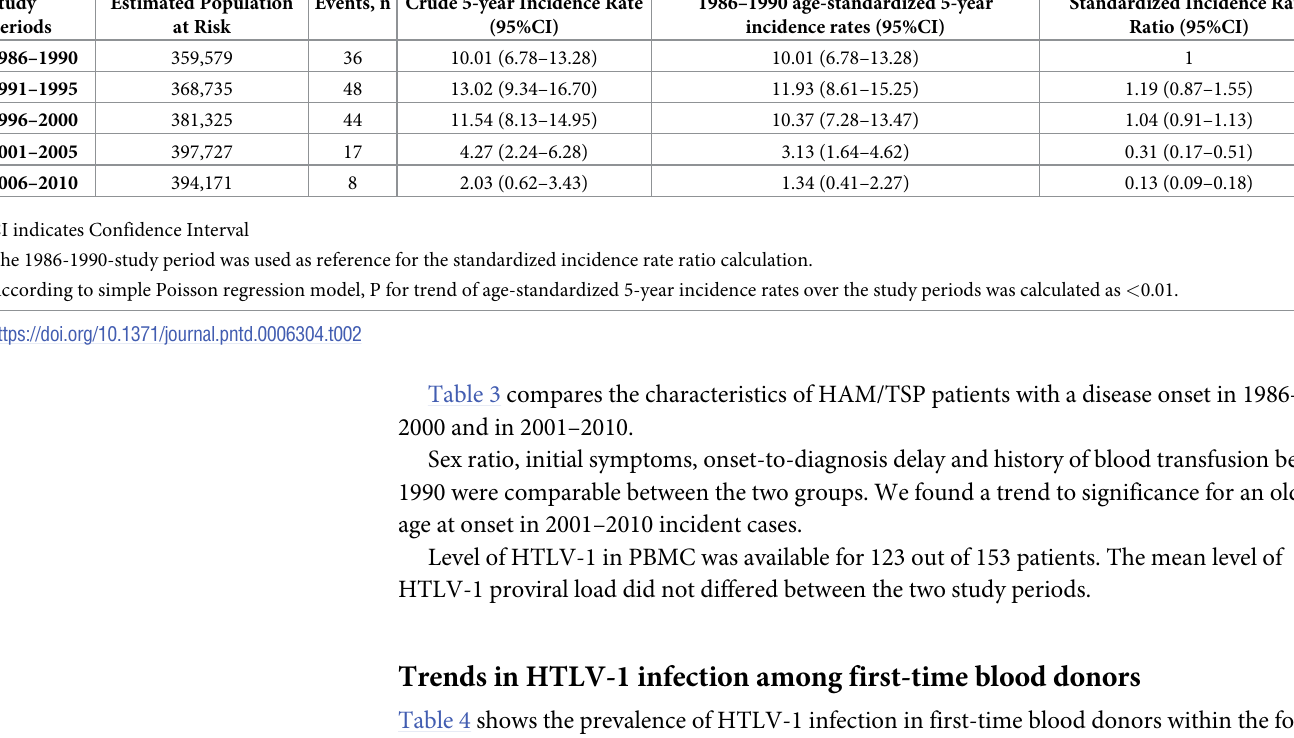
Table 2. Crude and age-standardized 5-year incidence rates and rate ratio of HAM/TSP in Martinique between 1986 and 2010. Study Periods